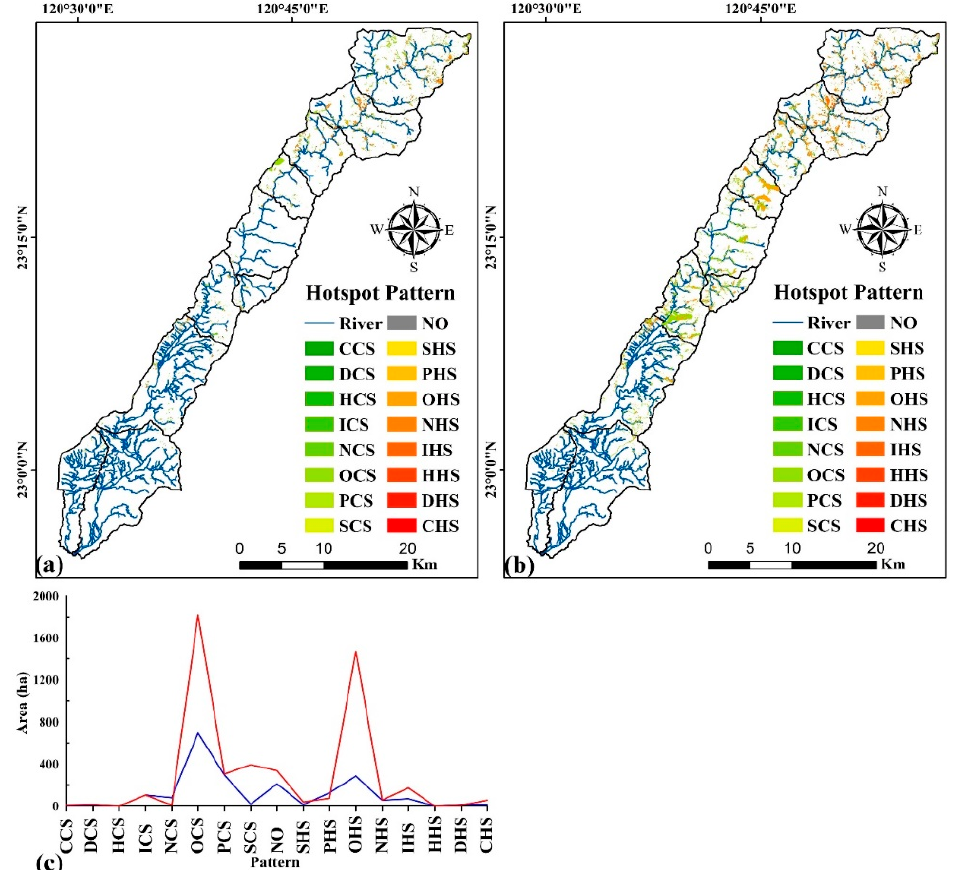
Figure 9. The patterns and distributions of landslide spatiotemporal hotspots in 1999~2008 ( a ) and 2008~2017 ( b ) in the Chishan river watershed. ( c ) shows the occupied percentage of each spatiotemporal hotspot pattern in 1999~2008 (blue line) and 2008~2017 (red line).